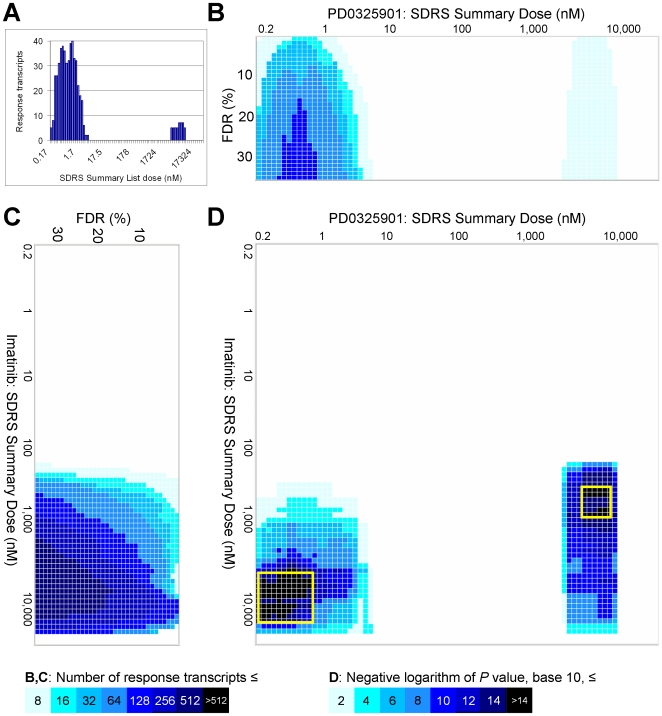
Characterization of the overall transcriptional responses to PD0325901 and imatinib, and a comparison between the two treatments.(A) Bar chart displaying the number of probesets whose F-statistic for goodness of fit to a sigmoidal curve passes a 10% FDR criterion at each SDRS Summary Dose. The results shown are from a four hour treatment with PD0325901. These results are also presented as the tenth row of the heatmap in (B). (B–C) Heatmaps showing the number of probesets whose F-statistic for goodness of fit to a sigmoidal curve passes the given FDR criterion at each SDRS Summary Dose. In (B), the horizontal axis contains the SDRS Summary Doses, and the vertical axis contains one row for each of the 35 FDR criteria applied. Panel (C) is rotated 90° to clarify its relationship to panel (D). The results shown are from a four hour treatment with PD0325901 (B) or a 20 hour treatment with imatinib (C). (D) The negative logarithm of P values from Fisher's exact tests that compare response transcripts for PD0325901 and imatinib. Values displayed are the lowest P value observed in tests performed between the (maximally) 35 lists of probesets that underlie each dose in panels (B) and (C). The horizontal and vertical axes contain the SDRS Summary Doses for PD0325901 (four hours) and imatinib (20 hours), respectively. The two boxed regions indicate shared transcript responses discussed in the text.